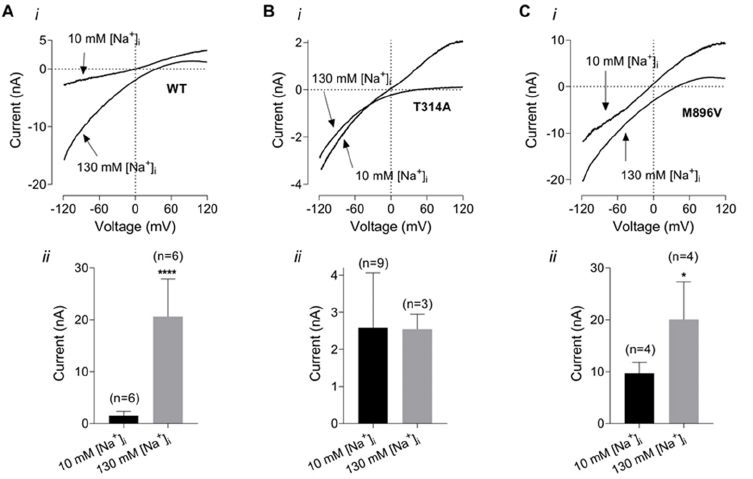
Figure 6. Dependence of WT and mutant KCNT1 currents on intracellular Na + concentration. ( A ). WT KCNT1. ( B ). T314A KCNT1. ( C ). M896V KCNT1. The I-V plots (i) were recorded in response to